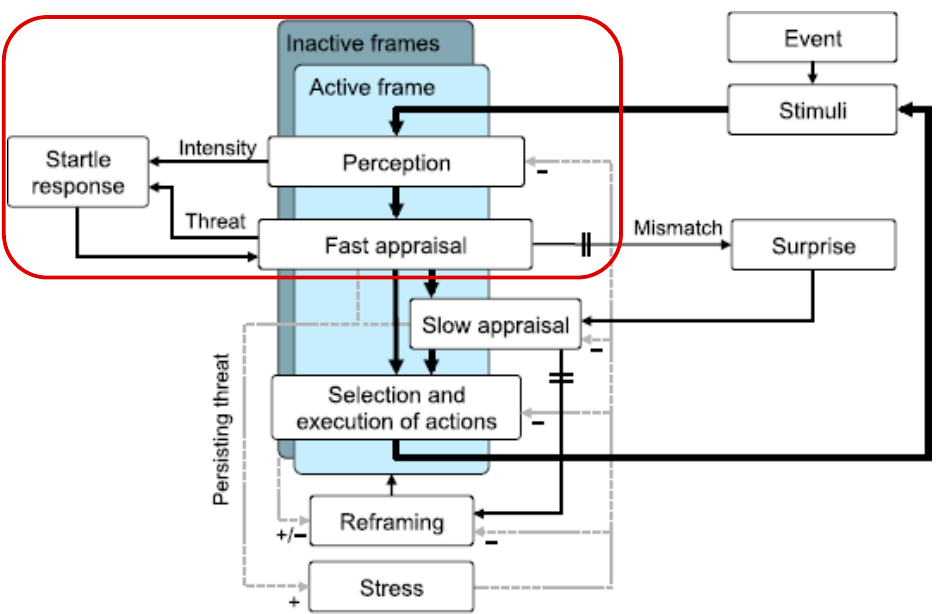
Figure 1. Startle (red boundary) pathway relative to surprise. Adapted with permission from Landman et al., 2017. Copyright 2017 Human Factors.